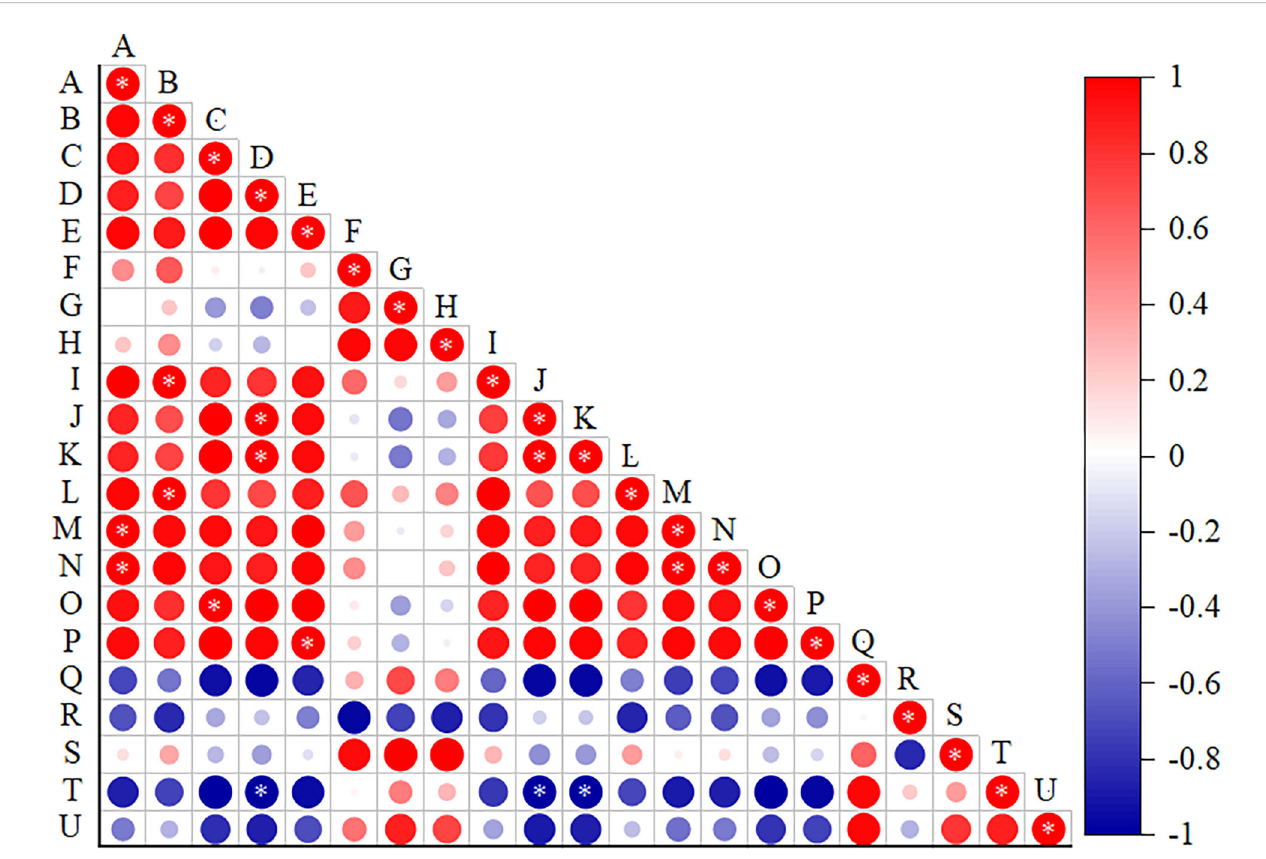
FIGURE 12 Correlation analysis of the leaf microstructural indicators and expansin genes. (A) Salt concentration, (B) Ue thickness, (C) Le thickness, (D) leaf thickness, (E) Pt thickness, (F) St thickness, (G) Pt/St, (H) CTR, (I) SR, (J) MV thickness, (K) VB thickness, (L) Ph thickness, (M) X thickness, (N) TP thickness, (O) X/Ph, and (P – U) expression levels of EXLA2 , EXPA8 , EXPA3 , EXPA15 , EXPA16 , and EXPA10 . Data were analyzed by a Student ’ s t-test; a p <0.05 was considered as statistically signi fi